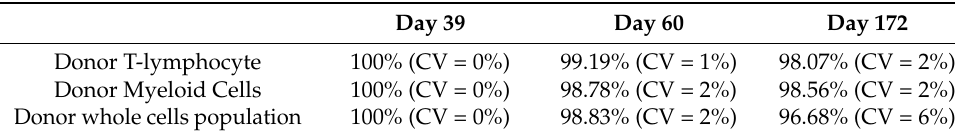
Table 1. Post-transplant chimerism results